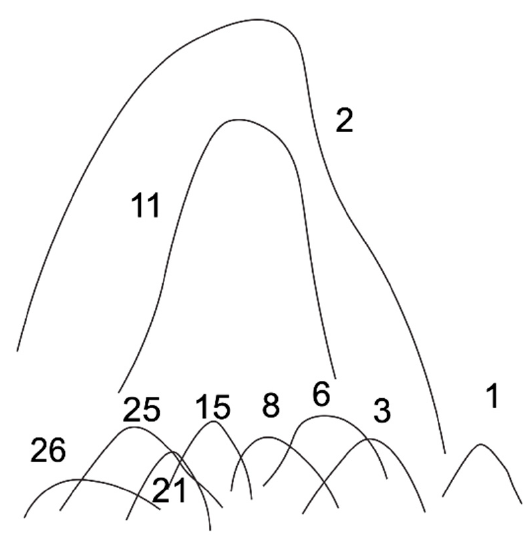
Figure 8. Two-dimensional immuno-electrophoresis precipitin lines. Drawing of some typical precipitant lines in two-dimensional immuno-electrophoresis of coccidioidin with anti-coccidioidin antisera. The antigens are numbered as described